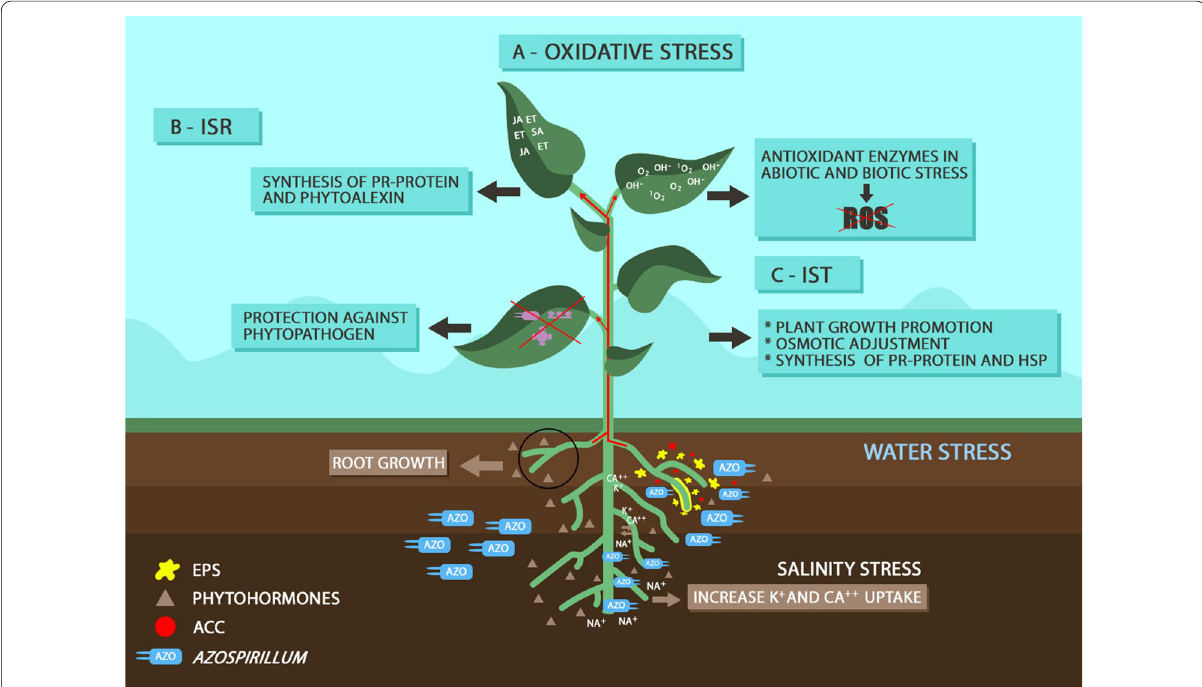
Fig. 1 Mechanisms of tolerance of biotic and abiotic stresses induced by Azospirillum in plants. Tolerance to biotic stress include induced systemic resistance (ISR), mediated by increased levels of phytohormones in the jasmonic acid (JA)/ethylene (ET) pathway independent of salicylic acid (SA), and systemic acquired resistance (SAR)—a mechanism previously studied with phytopathogens—controlled by intermediate levels of SA. Tolerance of abiotic stresses, named as induced systemic tolerance (IST), is mediated by antioxidants, osmotic adjustment, production of phytohormones, and defense strategies such as the expression of pathogenesis-related ( PR )